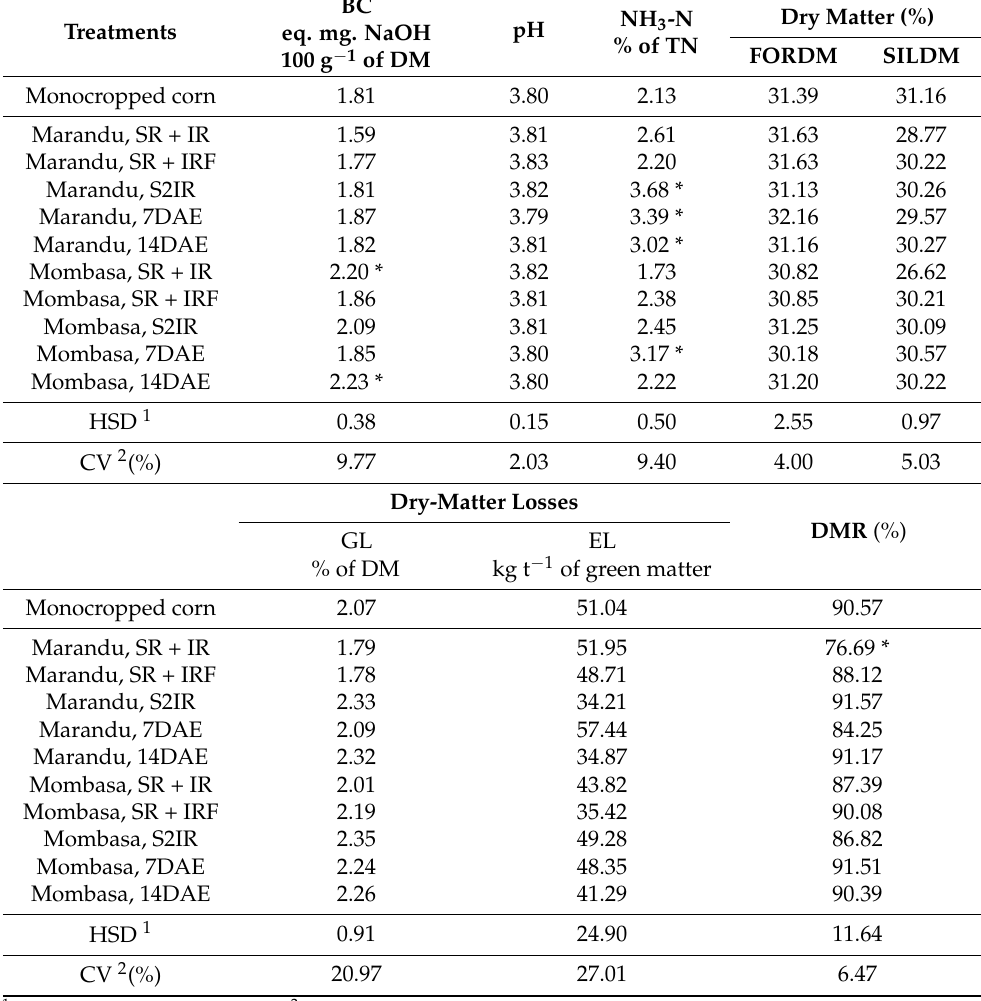
Table 2. Means of the treatments for the variables buffer capacity (BC), pH, ammoniacal nitrogen as part of the total nitrogen (NH 3 -N/TN) content, percentage of forage (FORDM) and silage dry matter (SILDM), gas losses (GL), effluent losses (EL), and dry-matter recovery (DMR) in corn ( Zea mays L.) ensilage intercropped with Marandu ( Urochloa brizantha ) and Mombasa ( Megathyrsus maximus ) grasses compared with the monocropped corn